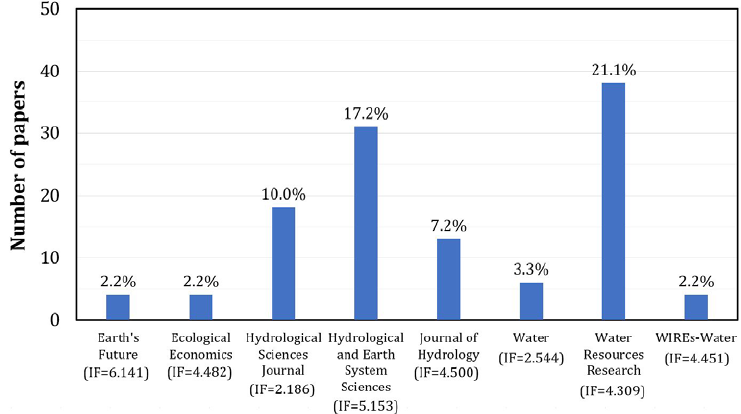
Figure 1. Number and percentage of socio-hydrology papers published in different journals. IF values show the impact factors of the journals in 2019 according to the Clarivate Analytics’ Journal Citation Report. Only journals that have published at least four papers are shown. In our literature search, we first searched for the keywords “socio-hydrology”, “socio-hydrology”, “socio hydrology”, “socio-hydrologic”, “socio hydrologic”, “socio-hydrologic”, “socio-hydrological”, “socio-hydrological”, and “socio hydrological” in the WoS database, resulting in 278 peer-reviewed journal papers. After reviewing these papers, we discarded those which did not focus on topics that are directly related to socio-hydrology. Our final database includes 180 papers, cited 3756 times overall based on WoS citation report, with 593 contributing